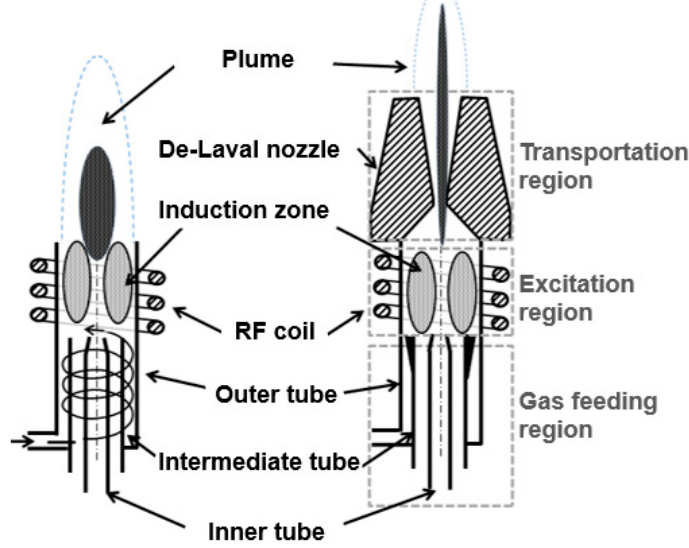
Figure 1. Regular ICP torch ( left ); ICP torch under investigation ( right ).